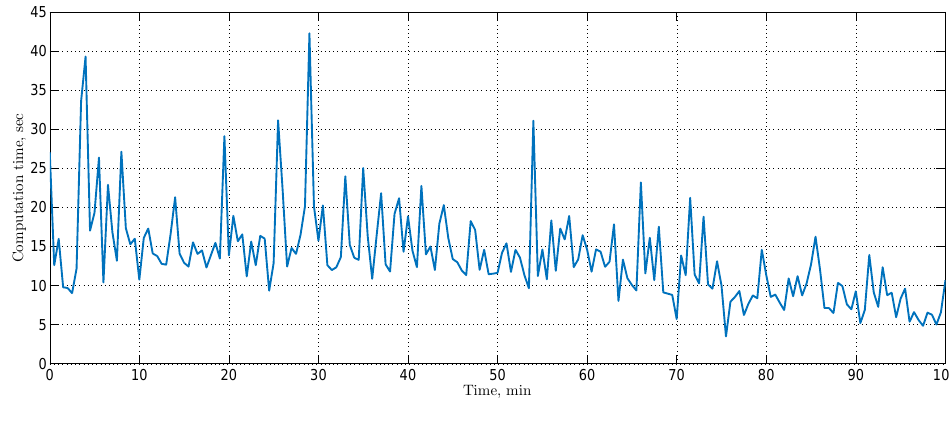
Figure 17: Computation time in each time step of MPC, where the inlet flow rate is a control signal.